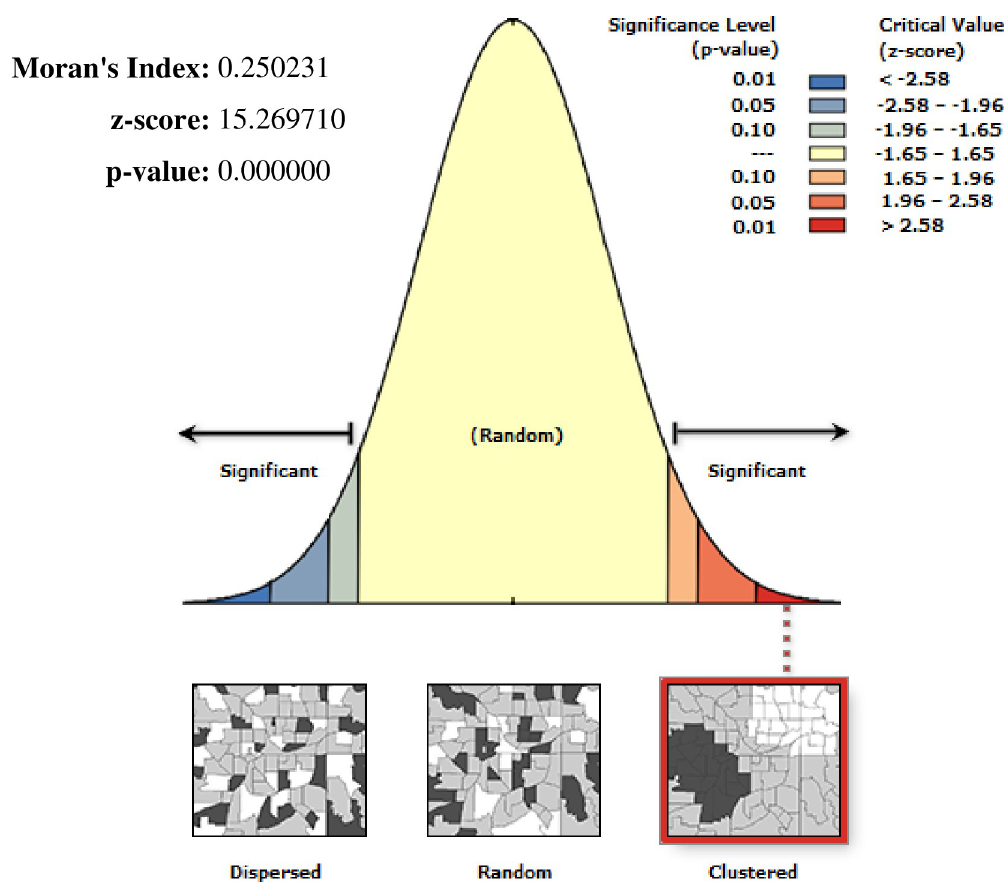
Fig 4. Spatial autocorrelation of unimproved drinking water source among households in Ethiopia, EDHS 2016, shapefile from 2018 GADM and plotted using ArcMap version 10.7 software.